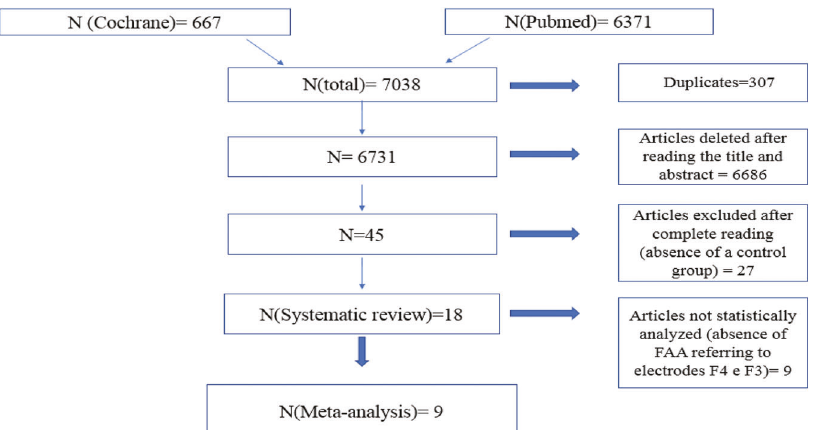
Fig. 1 PRISMA 2020 Flow Diagram. Studies included in the review. The meta-analysis was performed according to the PRISMA